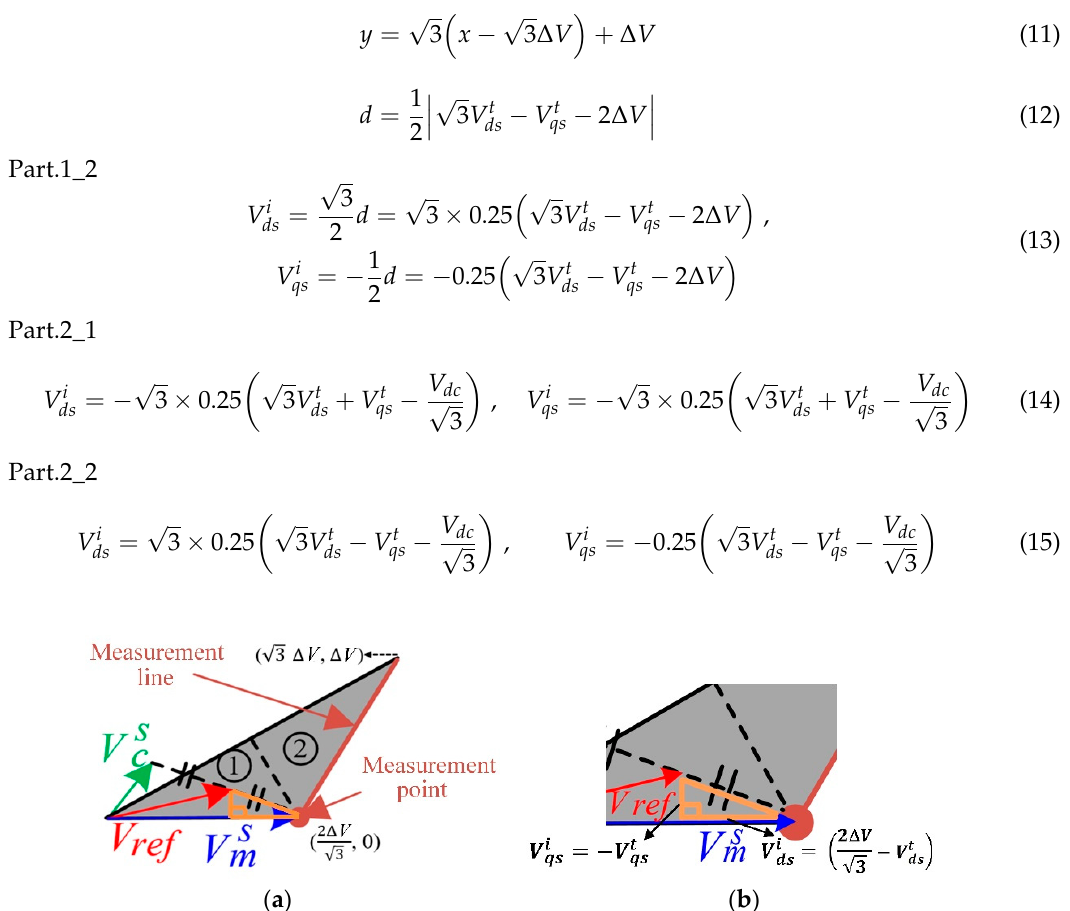
Figure 19. Optimal voltage injection method in Part.1_1. ( a ) Reference voltage vector on Part.1_1; ( b ) detailed view of the left one.